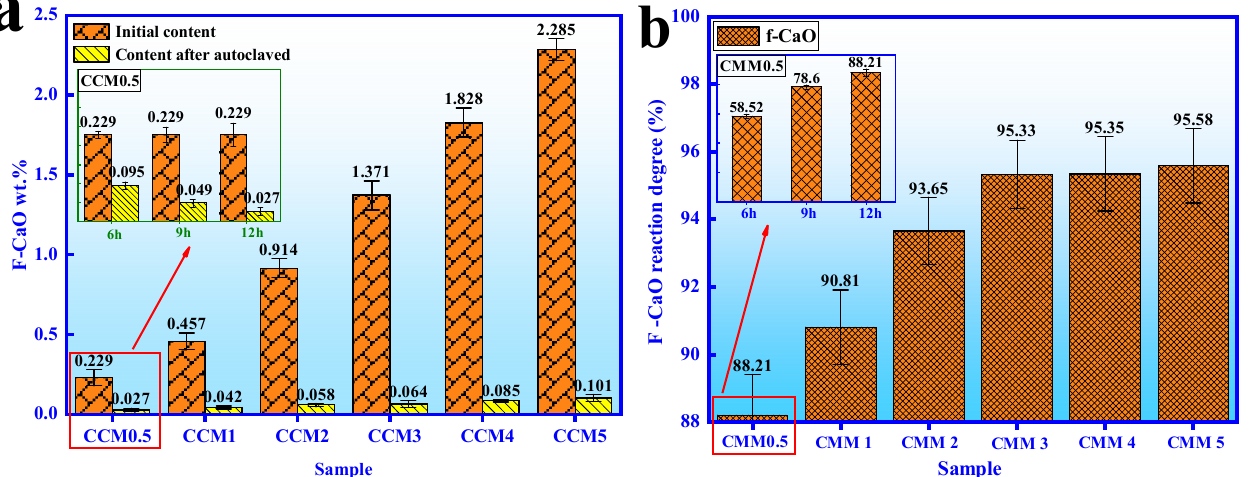
Figure 10. The f ‐ CaO content ( a ) and f ‐ CaO reaction degree ( b ) of CMM. Figure 10. The f-CaO content ( a ) and f-CaO reaction degree ( b ) of